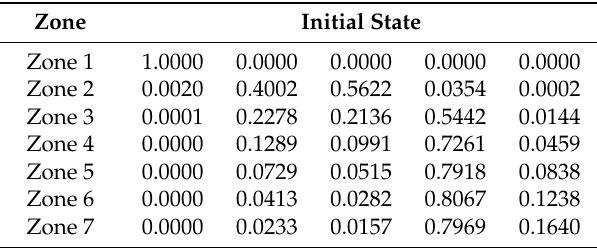
Table 3. Initial state of each zone.